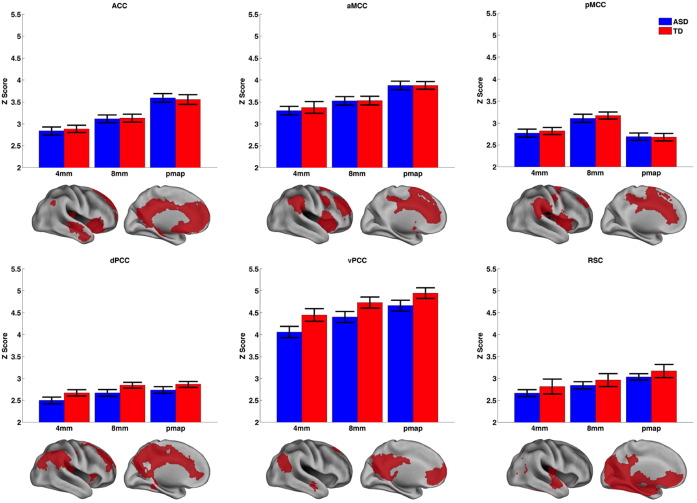
Connectivity strength for differently sized seeds. Bars show the average z value across voxels in each network for each different seed threshold. The network of voxels that are averaged is shown underneath each bar graph. The seeds tested included the probability maps shown in Fig. 2c, and a 4 mm and 8 mm radius sphere around the peak of the probability maps. Blue bars show ASD and red bars show TD individuals. Error bars show the standard error. (For interpretation of the references to colour in this figure legend, the reader is referred to the web version of this article.)